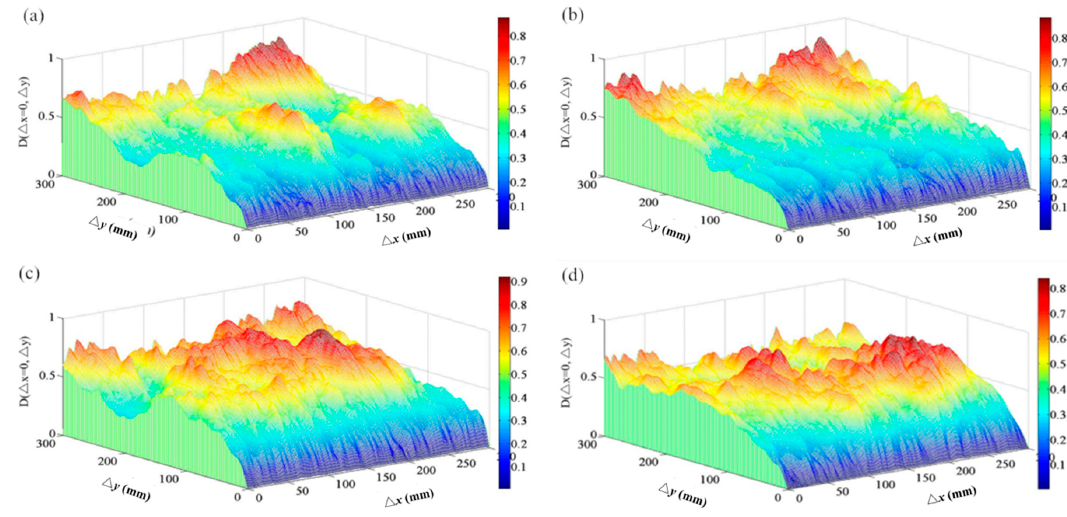
Figure 12. The second-order structure function change along the transverse direction in Runs 1–2: ( a ) Run 1-0; ( b ) Run 1-1; ( c ) Run 2-0; and ( d ) Run 2-1.